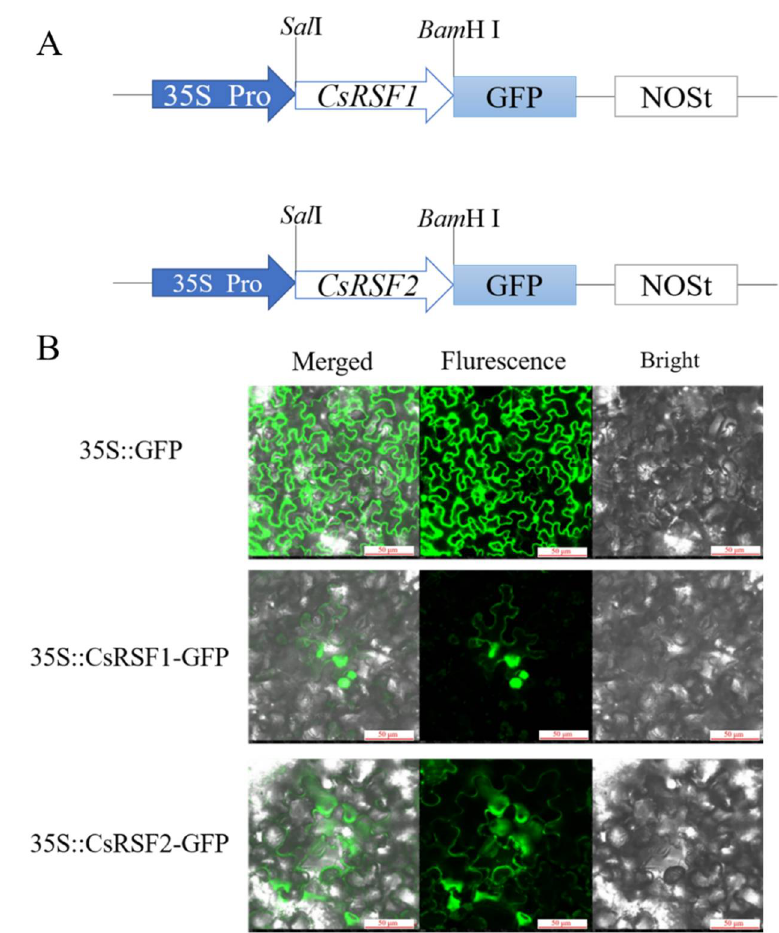
Figure 1. Subcellular localization of CsRSF1 and CsRSF2 in the Nicotiana benthamiana epidermis cell. ( A ) Schematic of p35S:: CsRSF1 -GFP and p35S:: CsRSF2 -GFP constructs used for the subcellular localization. ( B ) Green fluorescence protein (GFP) was detected in the N. benthamiana cell of the 35S::GFP, 35S:: CsRSF1 -GFP and 35S:: CsRSF2 -GFP constructs. Fluorescence, bright-field and merged images were obtained using a Leica confocal microscope. Bars = 50 µm.